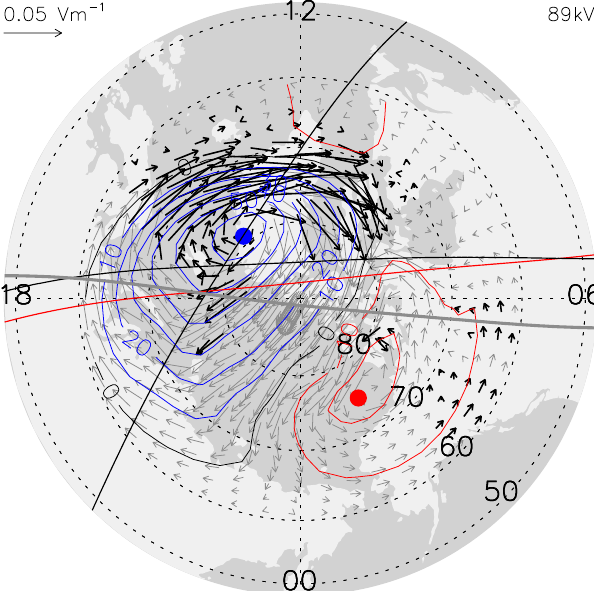
Fig. 11. Electric field data (rotated by 90 ◦ counter clockwise) derived from SuperDARN data averaged over the period 13:00– 14:00 UT, 3 October, 2002 with electric potential contours over- layed. Vectors are bold at locations where radar returns were re-